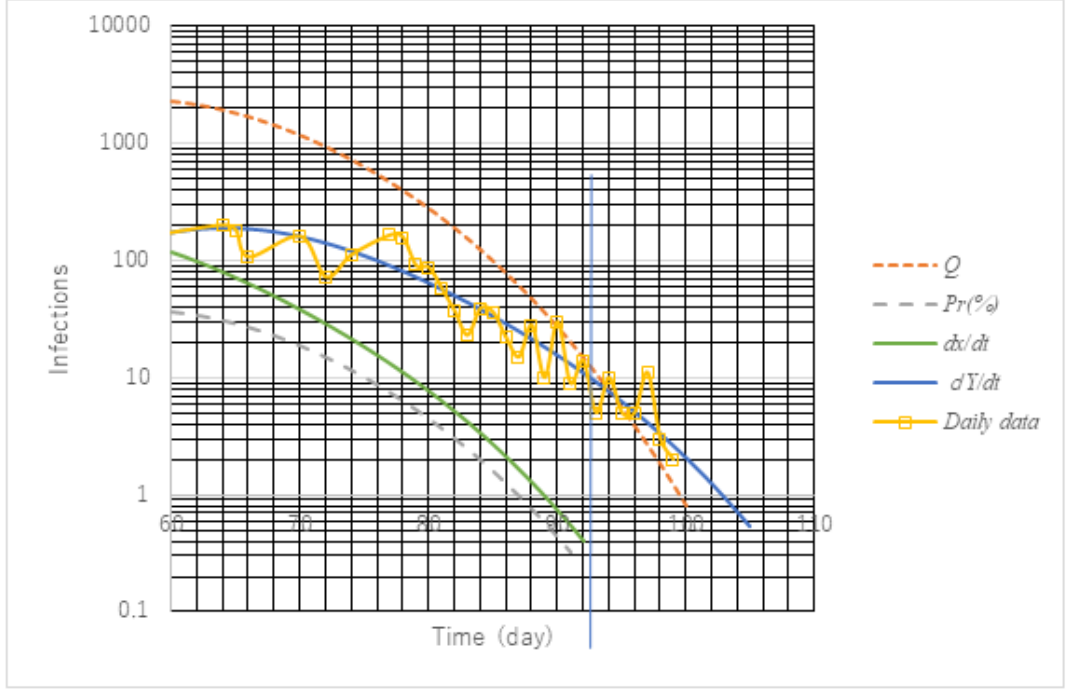
Figure 10. Trends of infectious variables as SARS-CoV-2 transmission declines. dx/dt represents a simulation of the actual trend of daily new cases. dY/dt was drawn with the curve dx/dt shifted to the right by 2 weeks. The daily data show daily new confirmed cases based on a positive polymerase chain reaction test. Both agreed well. The vertical blue line exhibits the date of rescission of the state of emergency declared by the Government of Japan. Then, the rescission criterion, that is, no more than 10 infections per day in terms of dY/dt , is satisfied. Infectious cases at large (Q), however, was estimated to have been 10 then according to the simulation. It should have been less than unity to aim for the extinction of SARS-CoV-2. To realize this, the rescission must be delayed by an additional